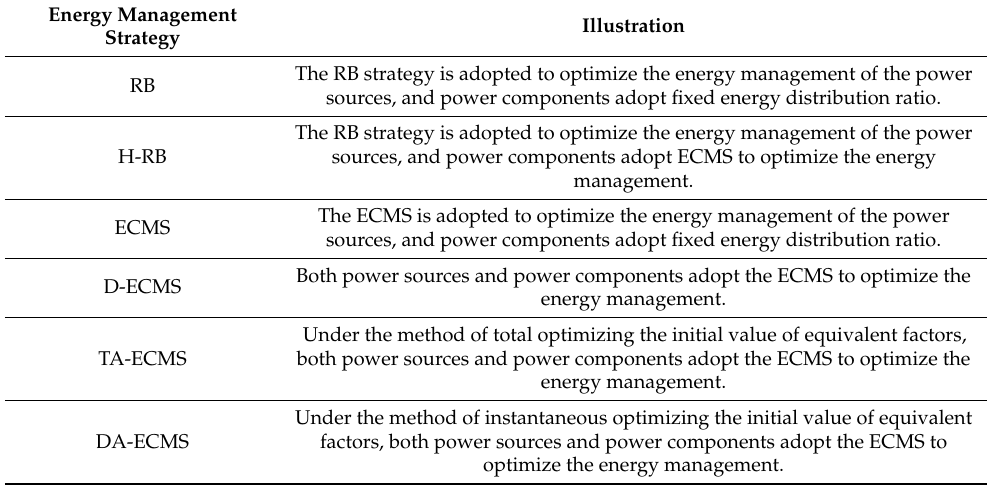
Table 4. Table of different control